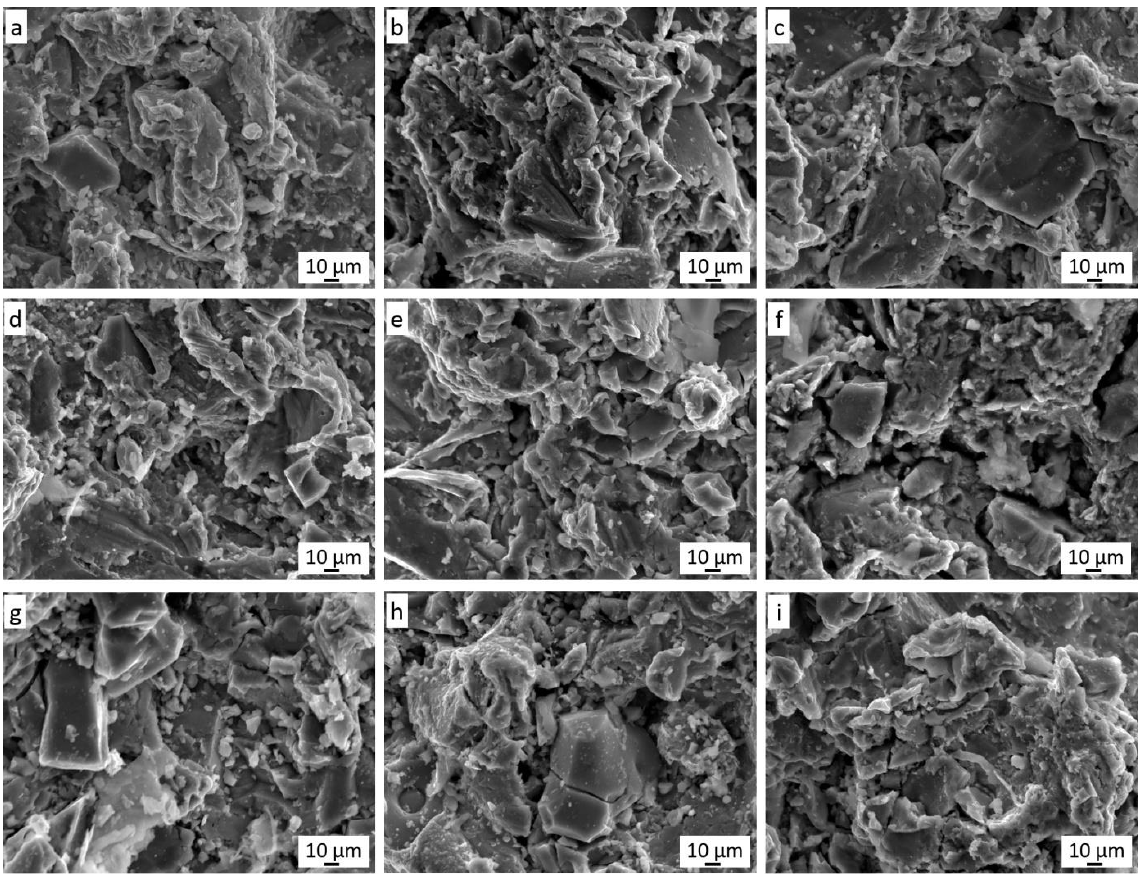
Figure 10. Surface morphology of Cr 3 C 2 -25(Ni20Cr)/Ni-25Graphite coatings ( a – i ) deposited with the parameter sets from 1 to 9, respectively.